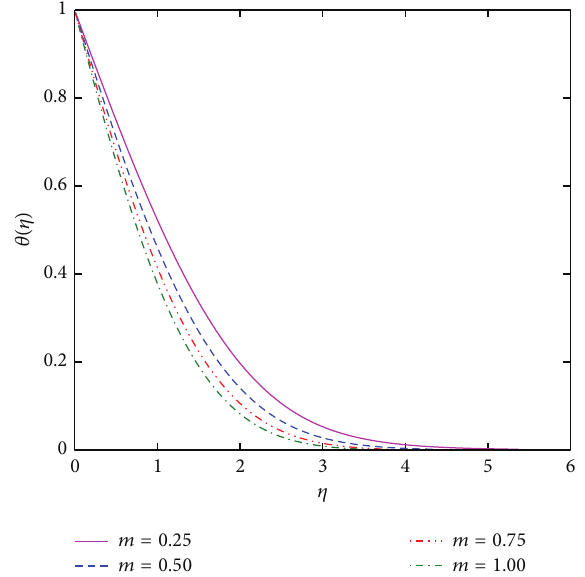
Figure 10: The effect of Pr on velocity profile when 𝑘 1 = 0.8 , 𝜆 𝑇 = 0.5 , and 𝑚 = 0.5 .